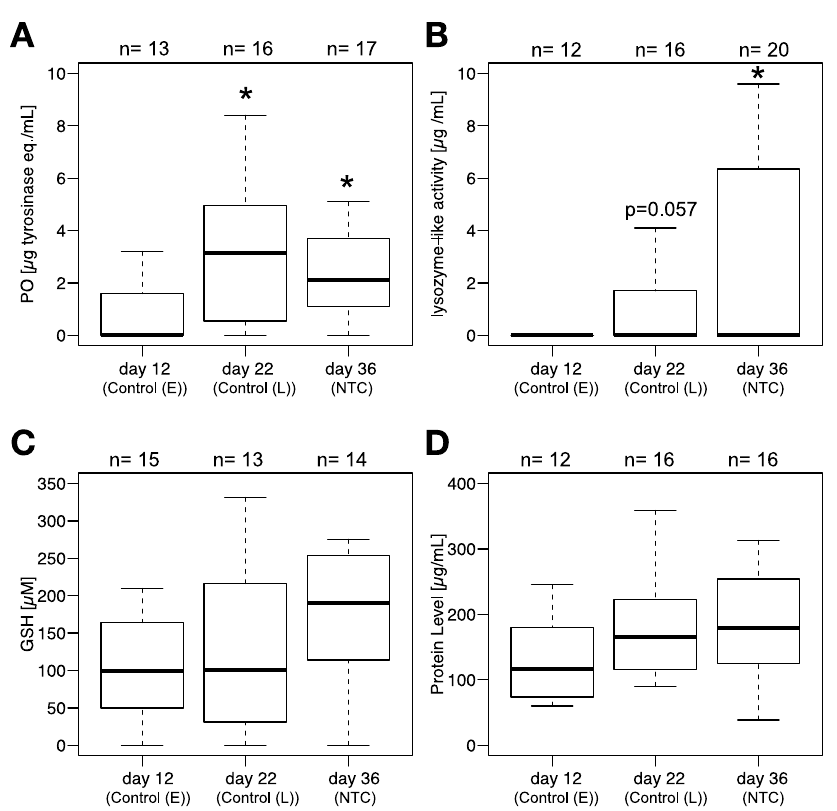
Fig 4. Age-dependent increase of PO and Lysozyme level. Age-dependent change in hemolymph immune measures. (A) PO level ( μ g (tyrosinase equivalent)/mL), (B)lysozyme-like activity ( μ g/mL), (C) GSH concentration ( μ M), and (D) protein concentration ( μ g/mL) are shown in the chart. Data for day 12 are from Control (E), data for day 22 are from Control (L), and data for day 36 are from NTC. activity and the lysozyme-like activity were increasing with age (A-B), while GSH and the protein concentrations did not show a significant trend (C-D). Statistical information is described in the Results section. The bars represents the 25 th and 75 th percentile, the central line in bold represents the median and the error bars denote the maximum and minimum values for each group. Sample sizes are indicated above each